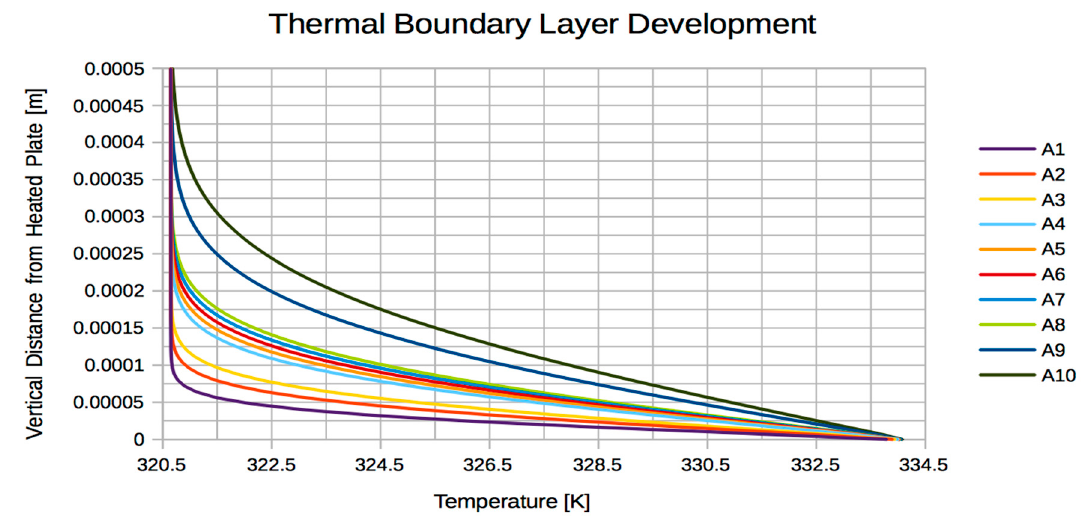
Figure 11. ITBL for each run of the Series A parametric numerical simulations. Energies 2017 , 10 , 272